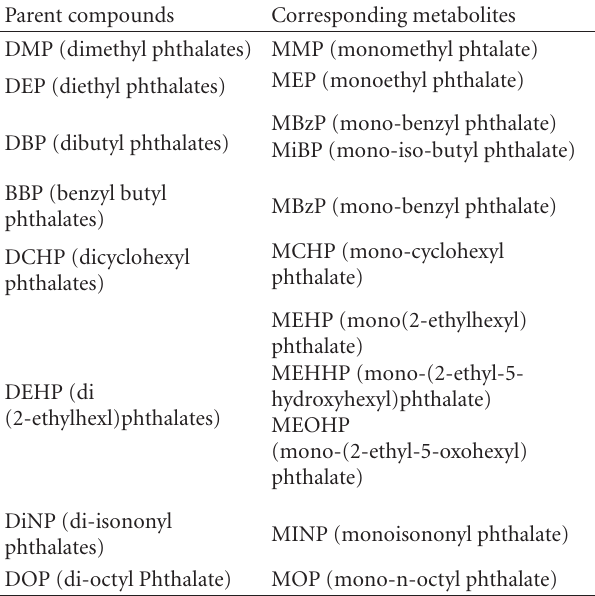
Table 2: Phthalate compounds